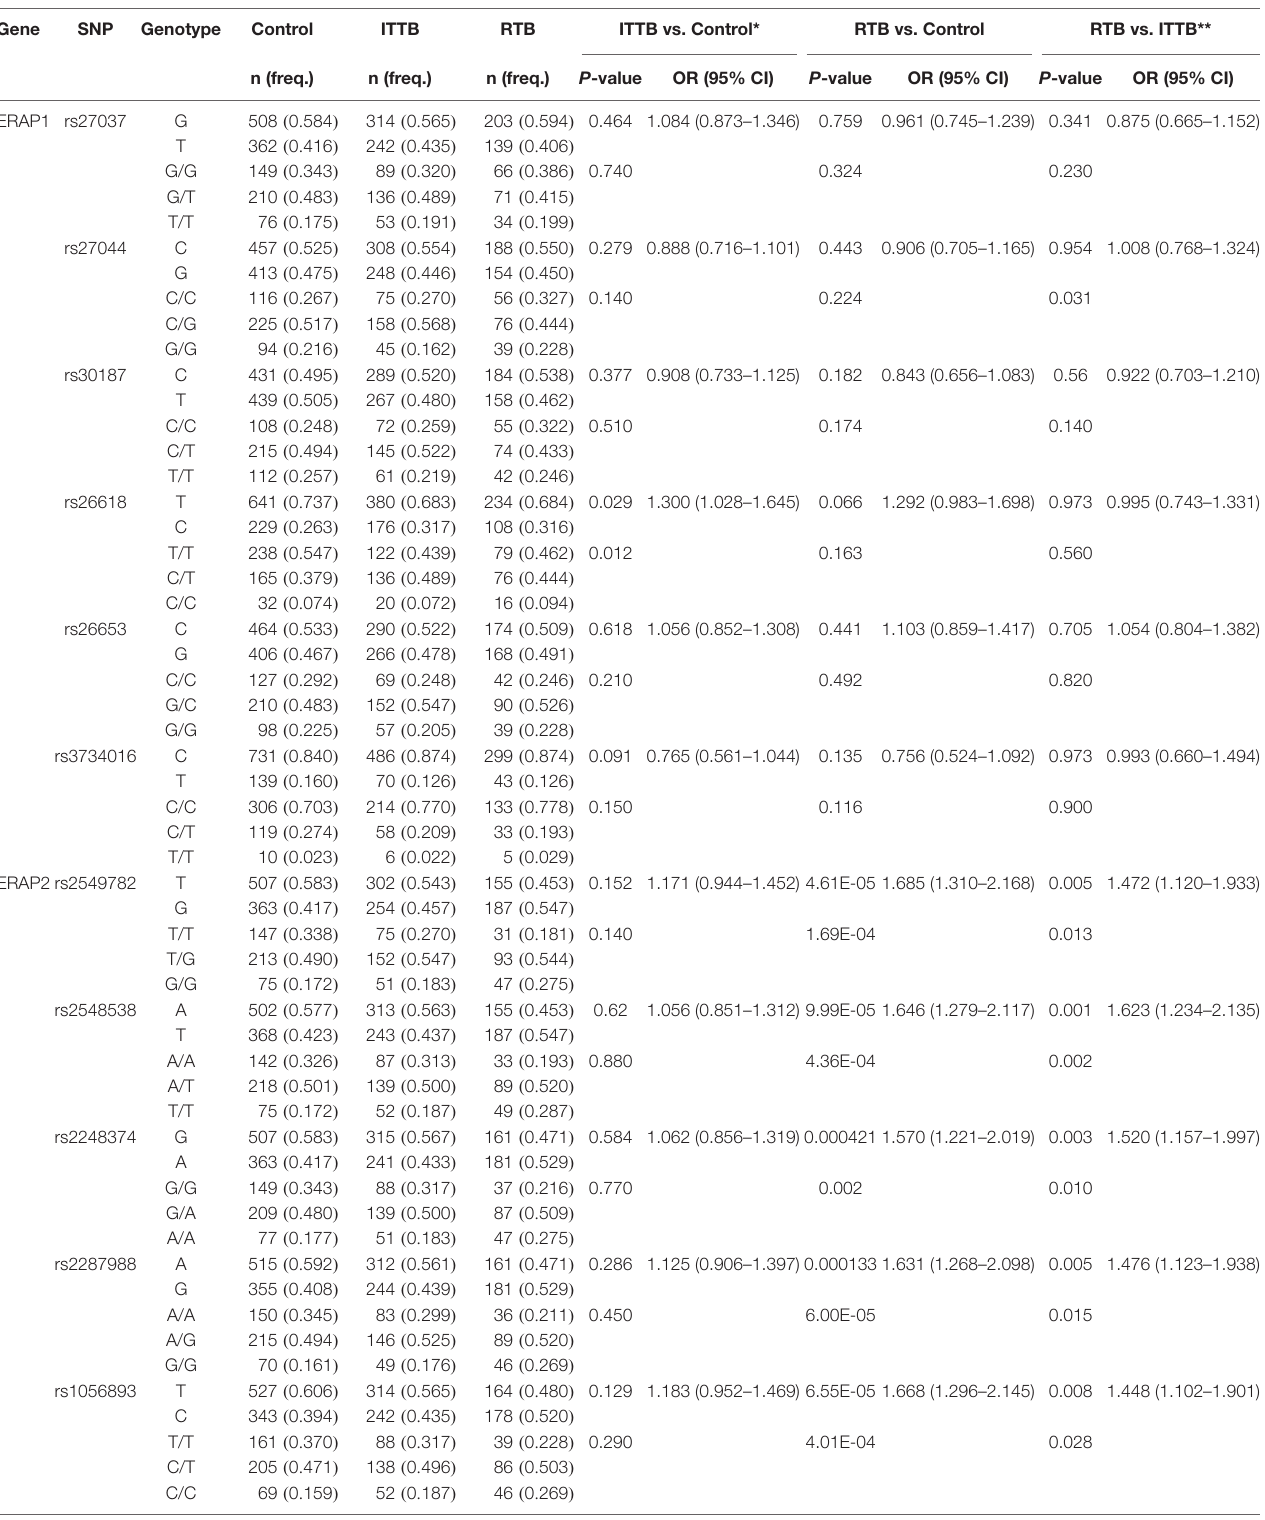
TABLE 6 | The allelic and genotype distribution of ERAP1 and ERAP2 genes among the control, PTB and EPTB groups.